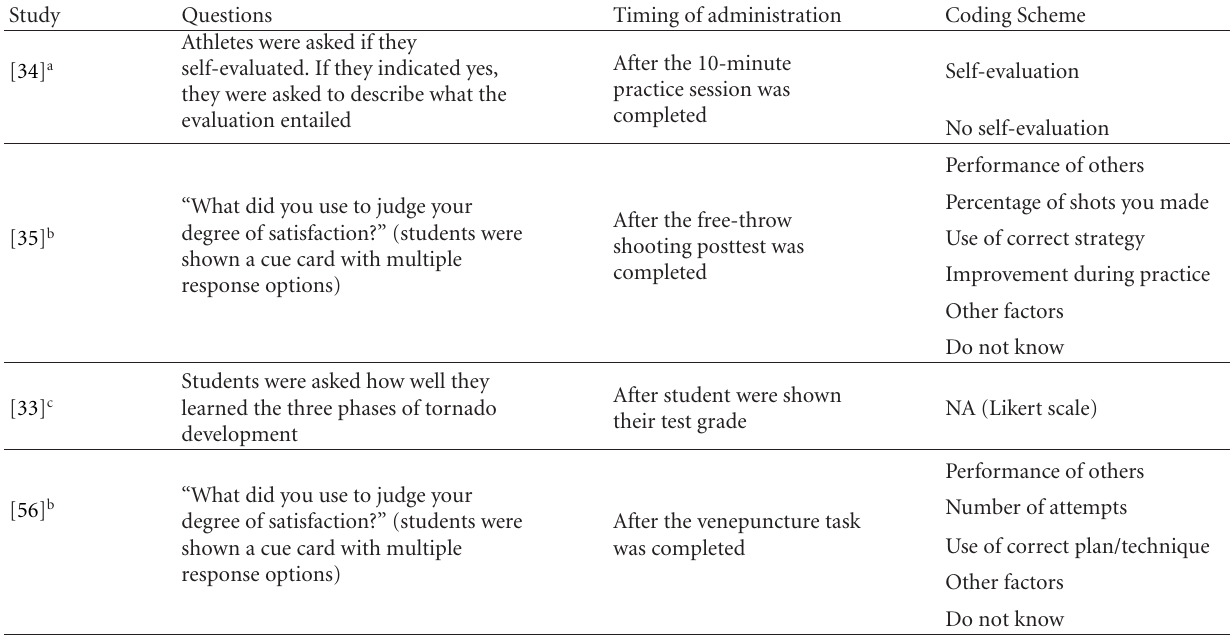
Table 5: Examples of self-evaluation microanalytic questions, administration sequence, and coding scheme.